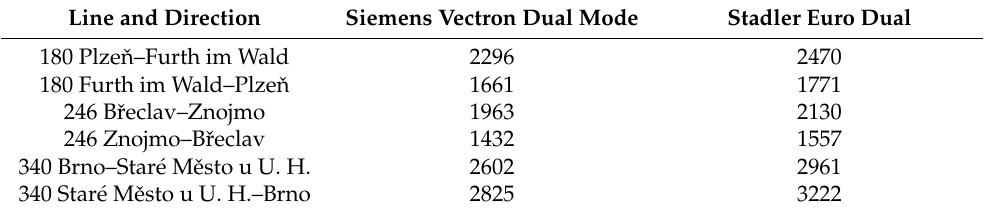
Table 5. Traction energy consumption [kWh] for running of the model train without intermediate stops. Source: Authors.